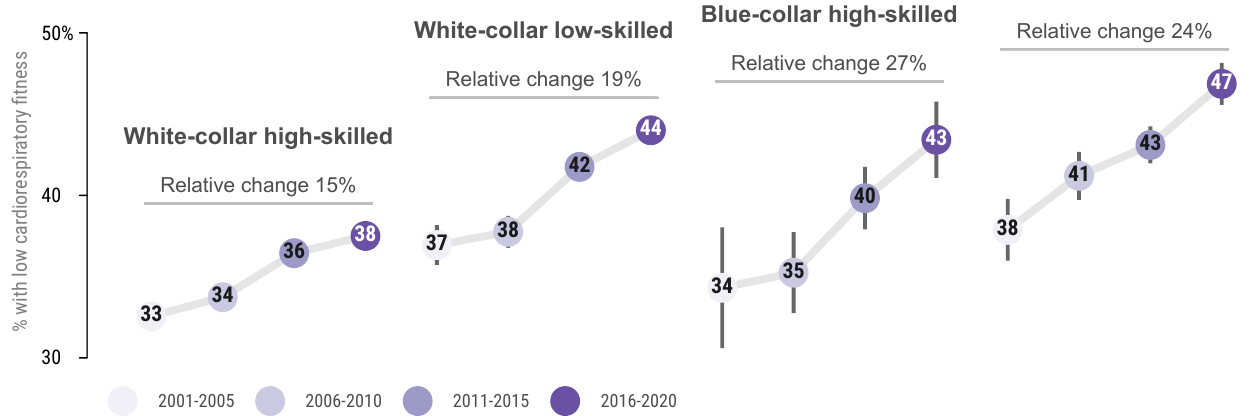
Figure 3. Proportion with, and relative change of proportion with low CRF (<32 mL/min/kg) by aggregated occupational groups over the study